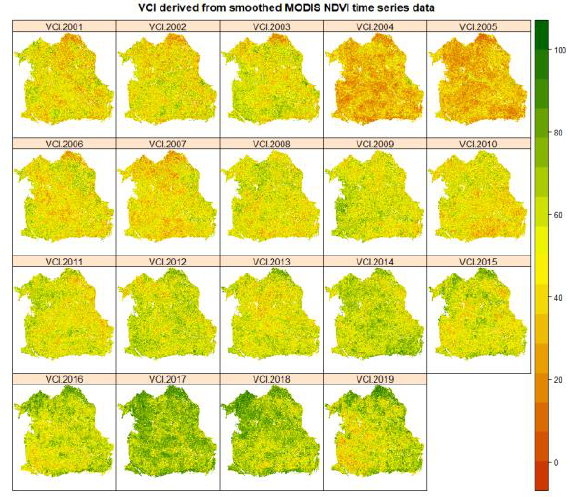
Figure 7. Long-term drought monitoring in Northeast Thailand from 2001 to 2019 derived from the mean annual vegetation condition index (VCI) (%).